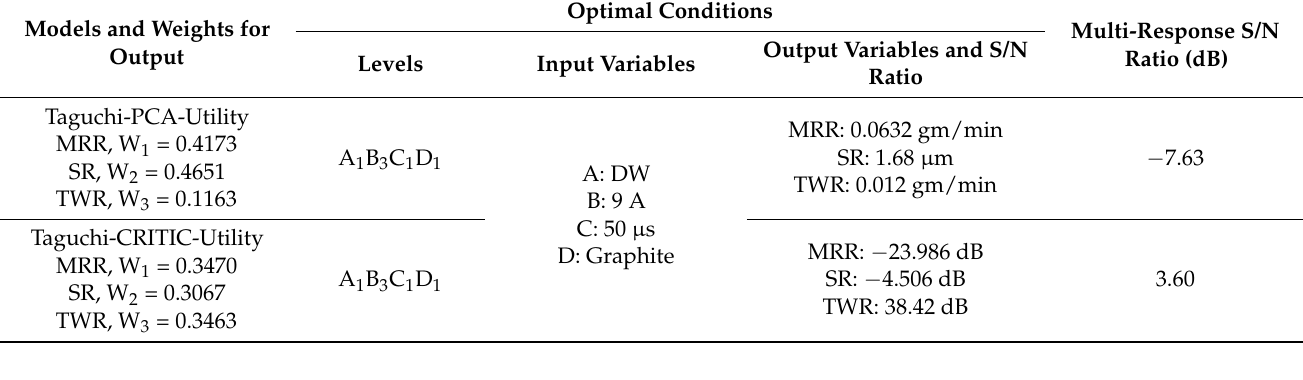
Table 18. Confirmatory experiments for the optimized EDM conditions.